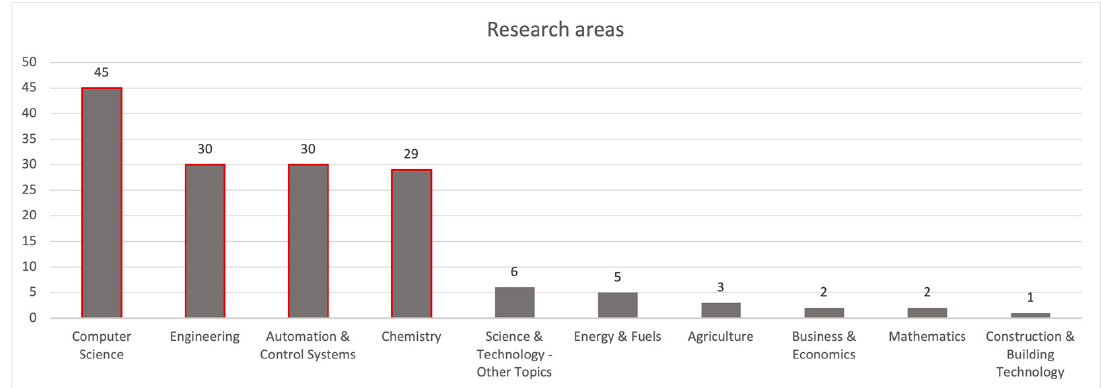
Figure 6. Research areas.